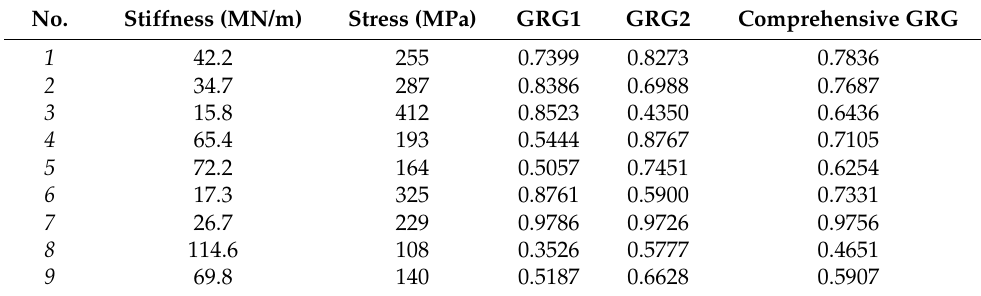
Table 4. Comprehensive GRG using GRA.